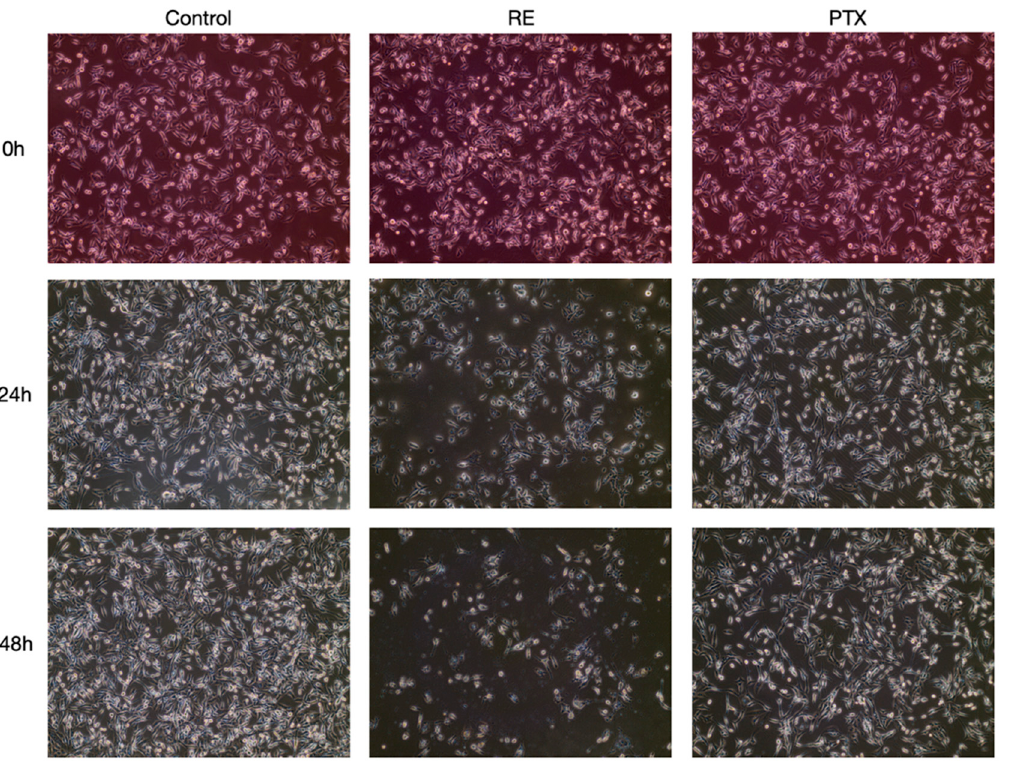
Figure 6. Effect of rosemary extract and paclitaxel on MDA-MB-231 cell morphology. Cells were seeded (200,000 cells/well) and after 24 h were treated without (control) or with RE (50 µg/mL) or PTX (10 nM) for 24 or 48 h. Photographs were taken immediately after treatment using an EVOS XL Core Cell Imaging System by Life Technologies (10× magnification).